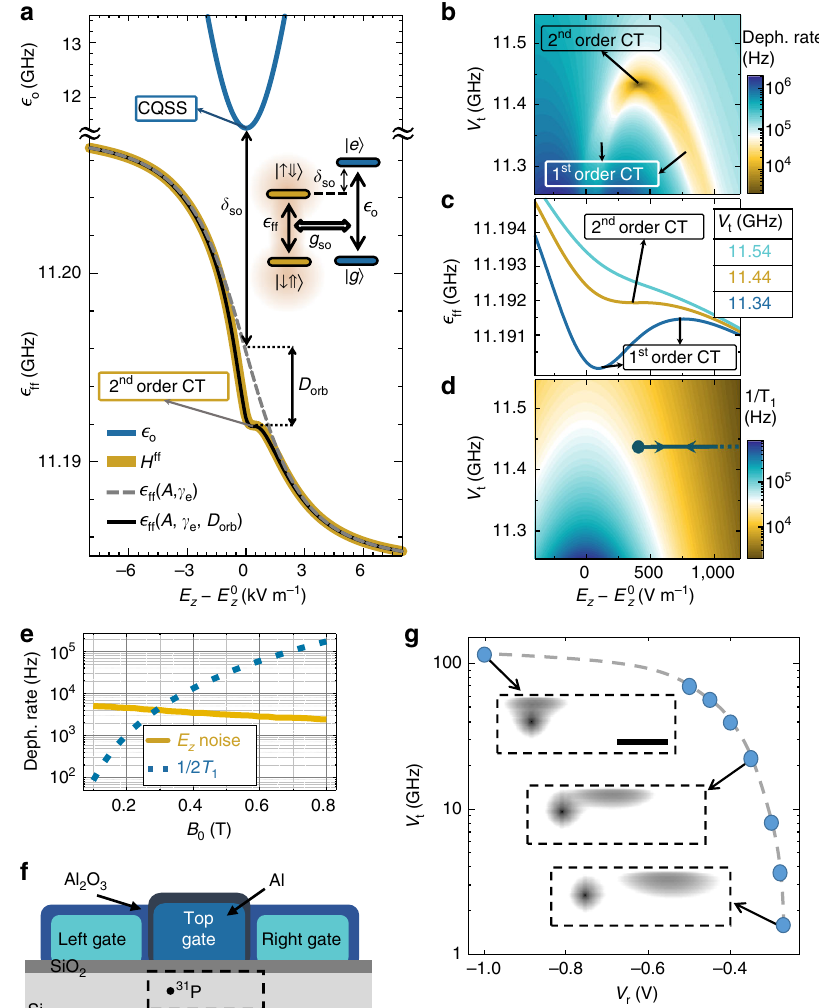
Fig. 2 Robustness to electric noise. a Charge, ϵ o , and fl ip- fl op, ϵ ff , qubit transition frequencies as a function of vertical electric fi eld E z , for B 0 = 0.4 T, A = 117 MHz, d = 15 nm, Δ γ = − 0.2% and V t = 11.44 GHz. The inset shows the level diagram of fl ip- fl op states coupled to charge states. CT stands for “ clock transition ” and CQSS for “ charge qubit sweet spot ” . b Estimated fl ip- fl op qubit dephasing rate, assuming electric fi eld noise E noise dependence of fl ip- fl op precession frequency for the three indicated tunnel coupling values. d Flip- fl op qubit relaxation rate, with arrows indicating the adiabatic path used for z -gates. e Flip- fl op qubit dephasing rate due to E z noise and relaxation, at second-order CTs for each B 0 . f Device structure to tune the tunnel coupling V t of the charge qubit. Scale bar is 30 nm. g V t as a function of right gate voltage, calculated using a fi nite element Poisson solver (Synopsis TCAD) and atomistic tight biding (NEMO-3D) 72 . The insets illustrate the NEMO-3D wavefunctions inside dashed region in f , for three right gate voltages V r = − 1, − 0.35 and − 0.27 V. The left gate voltage is V l = − 0.5 V for all the simulations, and the top gate is biased such that the position of the electron is in between the donor and interface. Scale bar is 20 nm. The donor is assumed to be z d = 9.2 nm below the Si/SiO 2